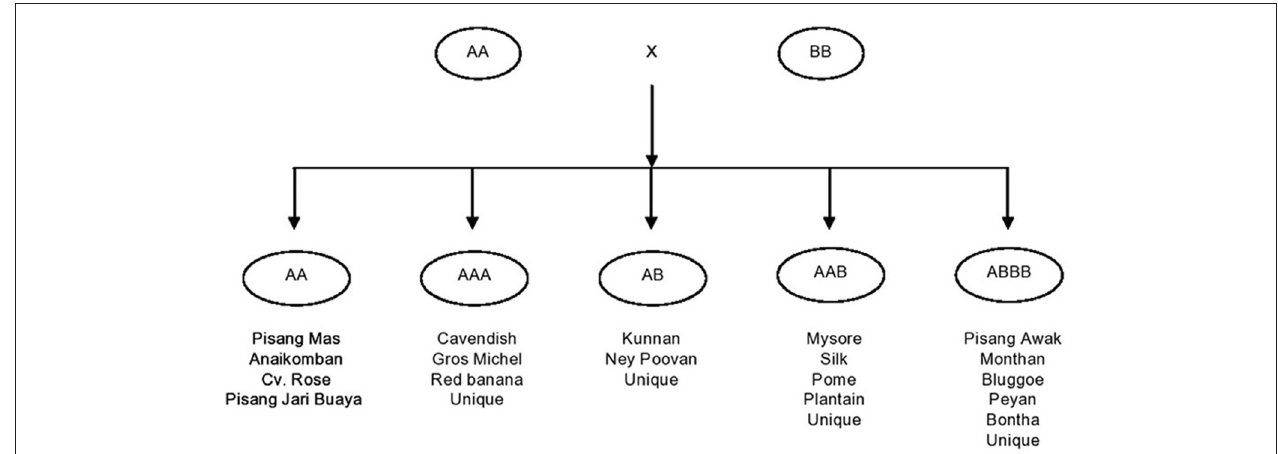
FIGURE 1 | Development of banana cultivars with the various major genomic